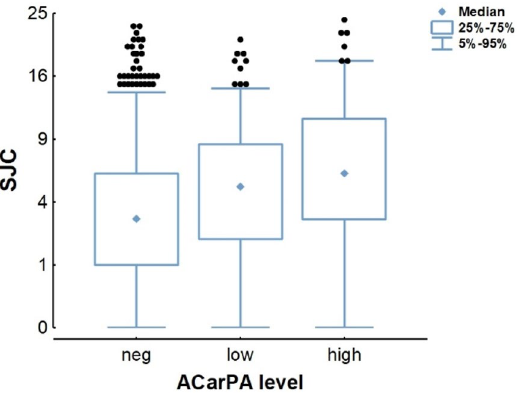
Figure 1. Increased SJC with high ACarPA titers. Box plots showing the SJC stratified in ACarPA − patients (n = 702) and ACarPA + patients with either low (n = 180) or high titers (n = 96). The median (diamonds), interquartile range (boxes), and 5–95% range (whiskers) are